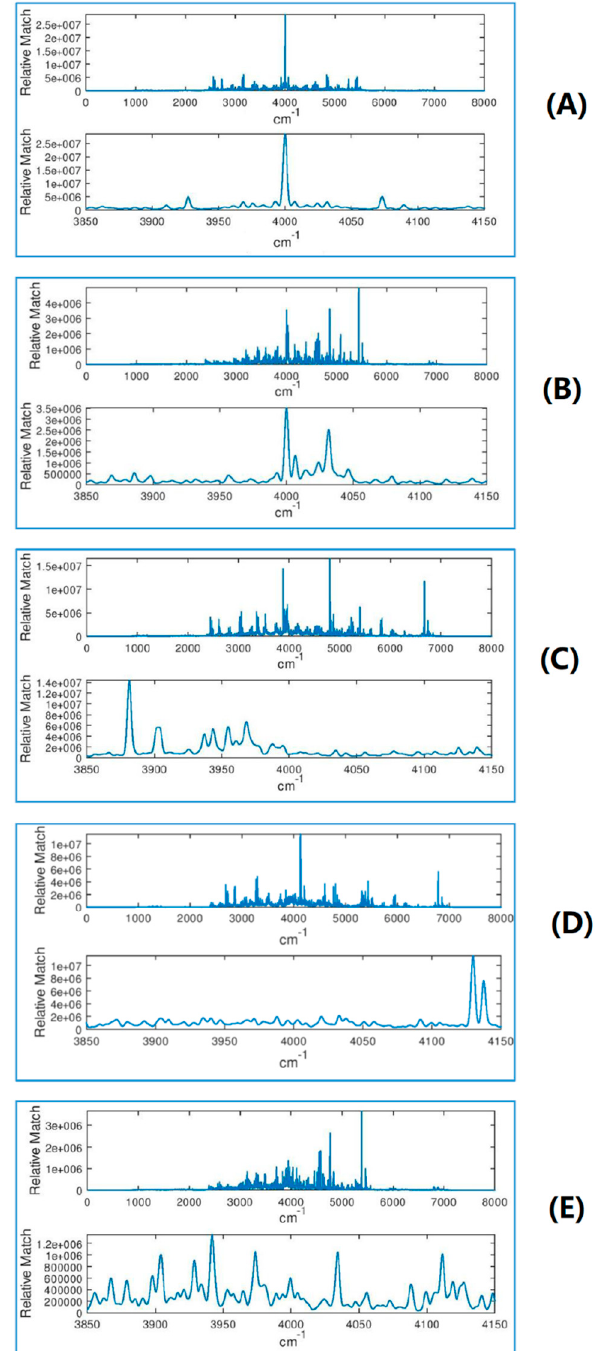
Figure 4. The correlation function of the reference spectrum (anharmonic spectrum computed with B3LYP/6-311G+(2d,2p)) with spectra computed at different levels of theory, using the full spectral range 0–4000 cm − 1 . From top to bottom: ( A ) B3LYP/anharmonic/6-311G+(2d,2p) (i.e., autocorrelation), ( B )_B3LYP/harm/6-311G+(2d,2p), ( C ) PBE/anharmonic/6-311G+(2d,2p), ( D ) B3LYP/anharmonic/6-31G, and ( E ) PBE/harmonic/6-31G. The top panel in each pair of plots is for the entire signal y and the bottom panel is zoomed around the center, where a peak is expected.